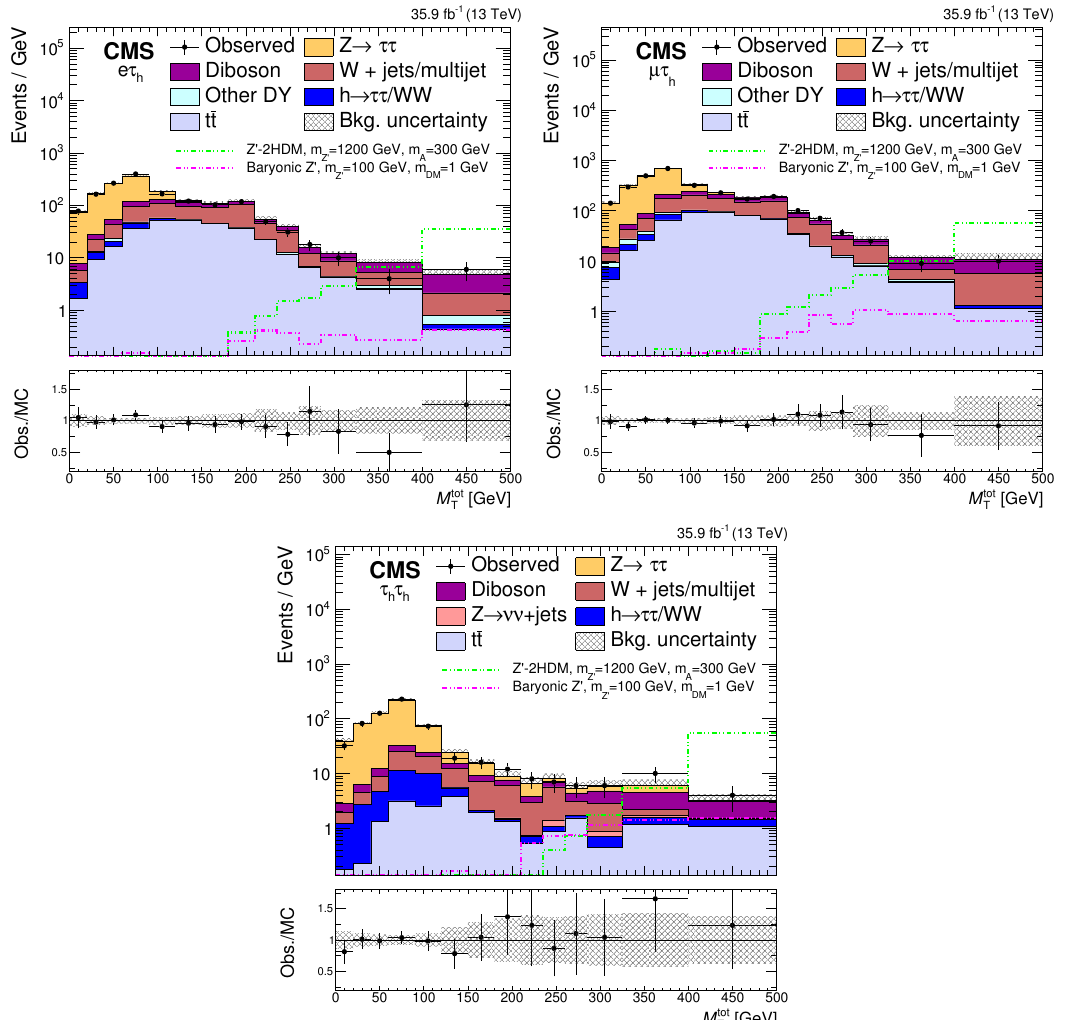
Figure 4 . Distributions of the total transverse mass M tot in the SR for the e (cid:28) h (upper left), (cid:22)(cid:28) h T (upper right), and (cid:28) h (cid:28) h (lower) (cid:12)nal states are shown after the simultaneous maximum-likelihood (cid:12)t. Representative signal distributions are shown with cross sections normalized to 1 pb. The data points are shown with their statistical uncertainties. The statistical uncertainty of the observed distribution is represented by the error bars on the data points. The over(cid:13)ow of each distribution is included in the (cid:12)nal 400{500 GeV bin. Single top processes are included in the \Diboson" contribu- tion. The \Other DY" contribution includes background from Z ! ‘‘ . The systematic uncertainty related to the background prediction is indicated by the shaded